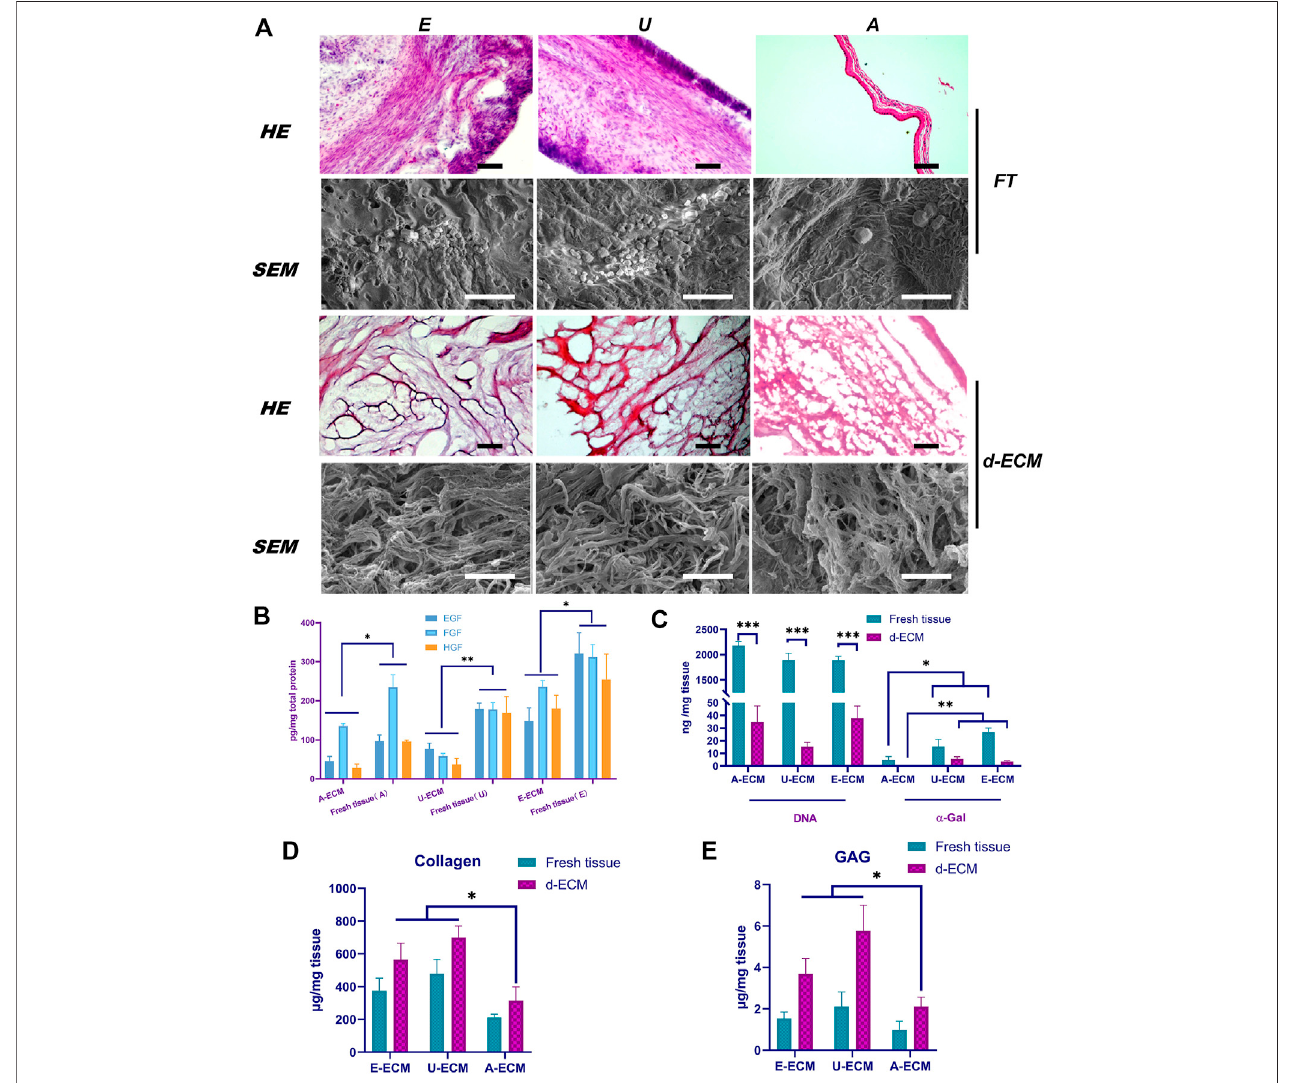
FIGURE 1 | Comparison of the d-ECM and corresponding raw tissue microstructures and compositions. (A) Evaluation of the decellularization effects and microstructural characteristics of the ECMs via HE staining and SEM. (B) Quantitative evaluation of residual active factors in the three ECMs. (C) After decellularization, the amounts of residual DNA and α -gal were compared among the three groups and in fresh tissues. (D,E) The protection of ECM components in tissues after decellularization.* p < 0.05,** p < 0.01,and*** p < 0.001,one-wayANOVAwithTukey ’ sposthoctest.Bar=400 μ m(Top)and50 μ m(low)intheHEimagesandbar = 5 μ m in the SEM image. FT, fresh tissue; A, amniotic membrane; E, endometrium-; U, urinary.